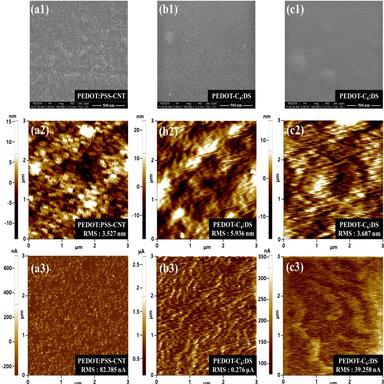
The FE-SEM images (a1, b1, c1) about surface morphologies and conductive AFM images of films coated on PVDF; topographical (a2, b2, c2) and current map (a3, b3, c3) images of PEDOT:PSS-CNT composite, PEDOT-C4:DS and PEDOT-C6:DS.